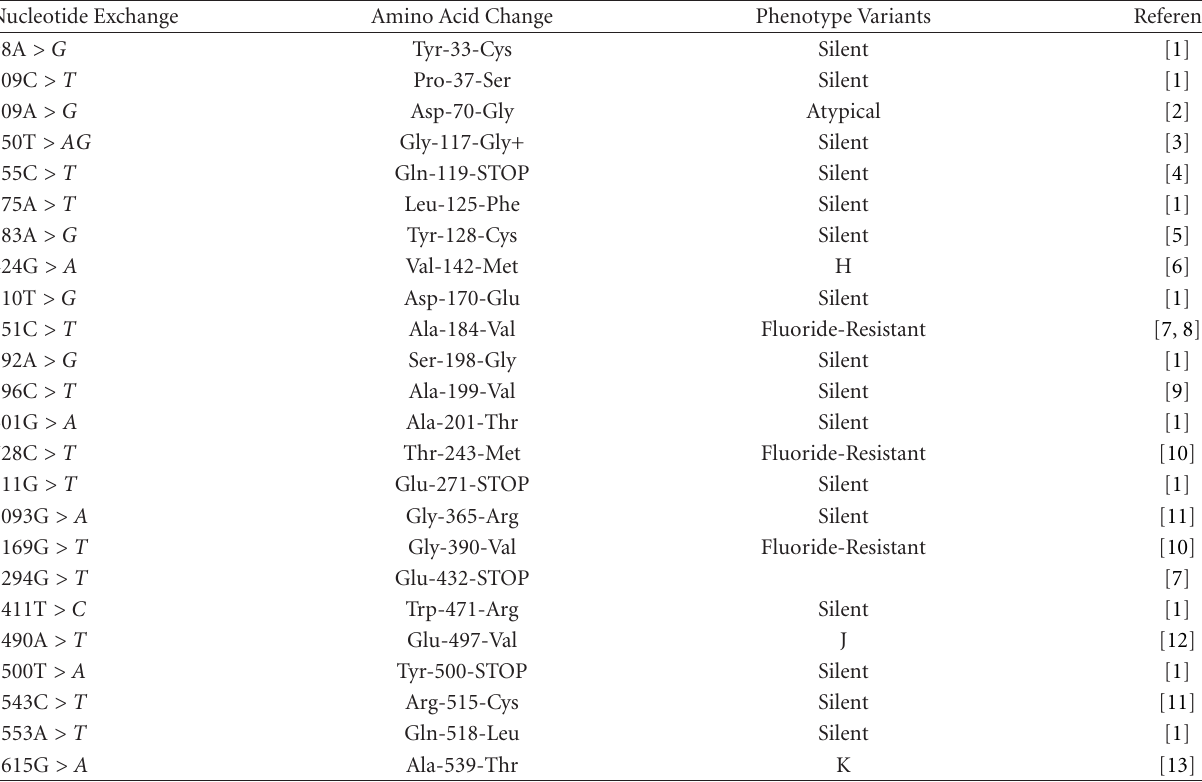
Table 1: Genotype—Phenotype Relation of Butyrylcholinesterase